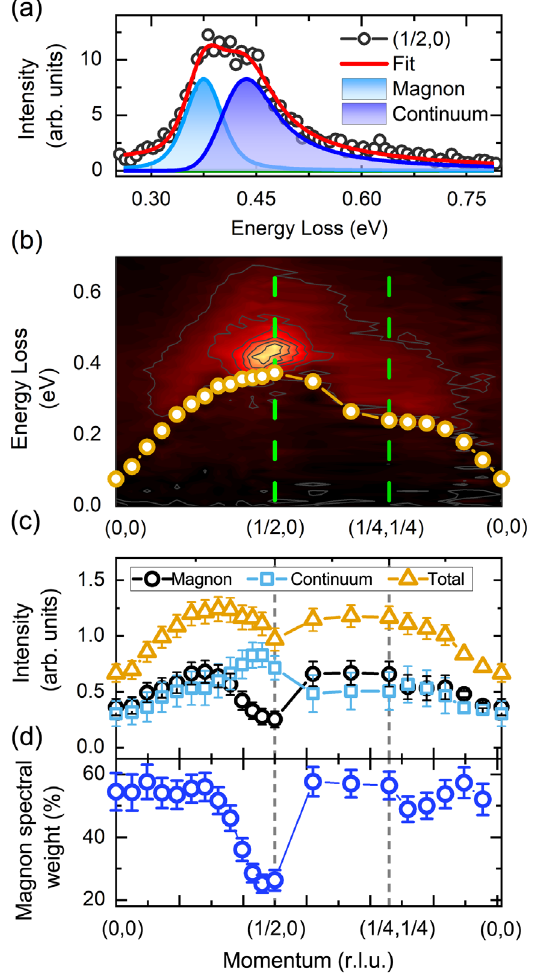
FIG. 3. (a) Example of fitting procedure of the spectrum at (0.5,0) collected with π polarization. The magnon peak and the continuum are reported in light and deep blue, respectively, and the resulting fitted curve is in red. (b) Momentum dependence of high-energy continuum. Elastic, phonon, and magnon peaks have been removed for clarity. The energy of the magnon is shown by yellow dots. For clarity, the scans have been normalized to the atomic πσ 0 RIXS cross section, which slightly modulates the intensity but only depends on experimental geometry [46]. (c) Intensity (determined as the area below the curves) of the magnon, of the continuum, and of the total of the magnetic excitations as a function of momentum. (d) Ratio between the weight of the magnon peak and the total weight of the magnetic